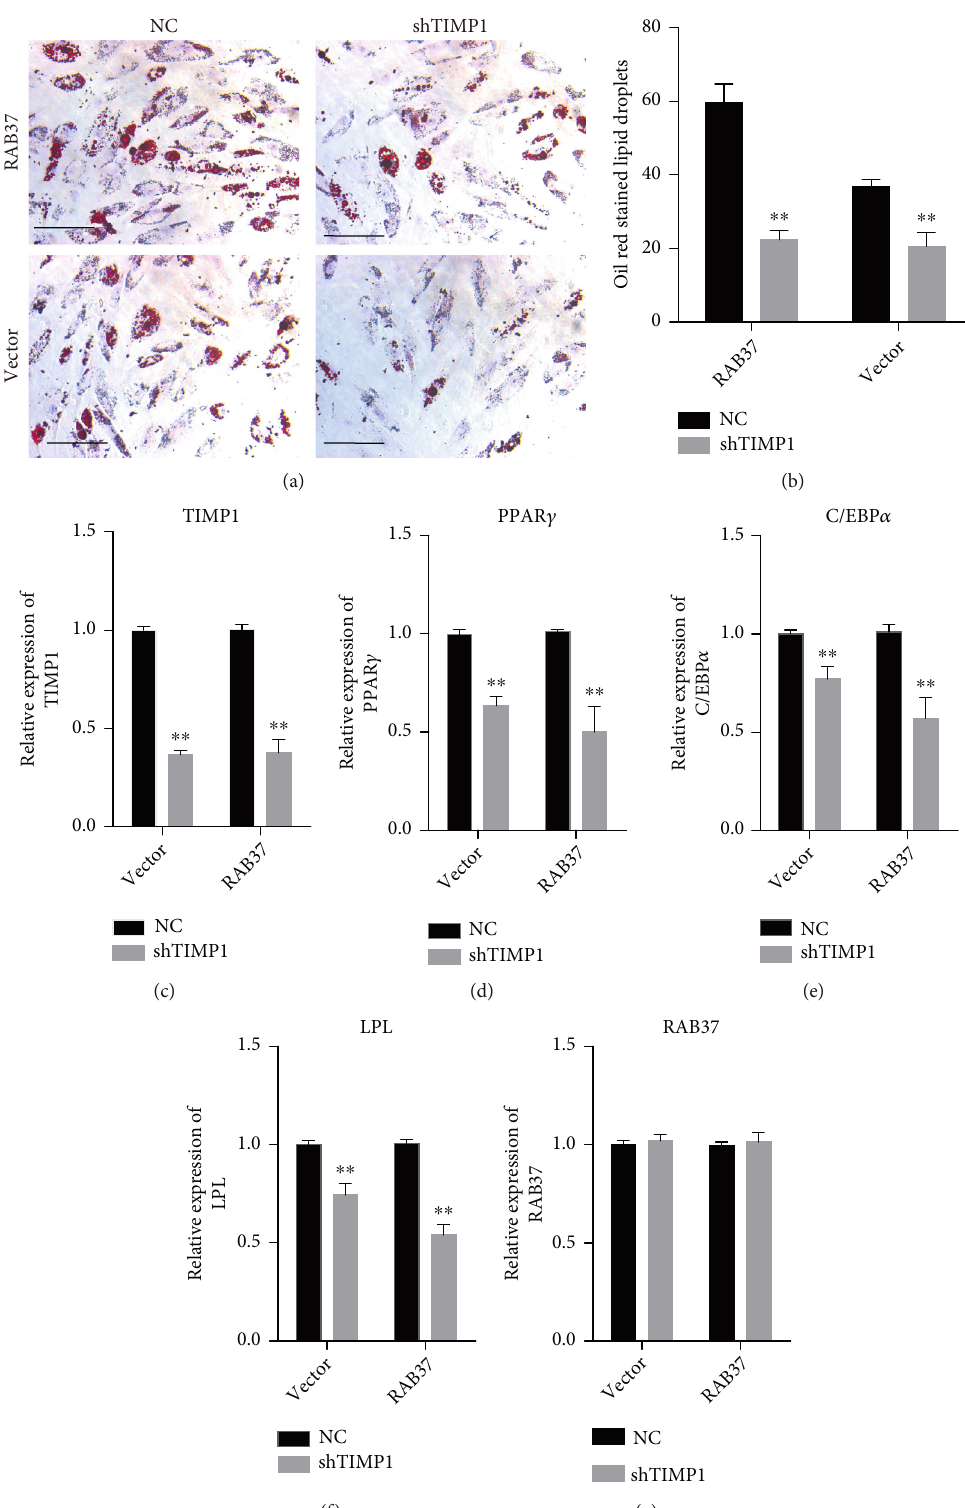
Figure 4: Knockdown of TIMP1 compromised RAB37-mediated adipogenic di ff erentiation. The lentivirus expressing shRNA targeting TIMP1 (lv-shTIMP1) was used to inhibit endogenous expression of TIMP1 in hADSCs-RAB37 and hADSCs-vector. Lentivirus expressing a scramble RNA (NC) was used as control. Adipogenic di ff erentiation was evaluated by Oil Red O staining (a) ( scale bar = 300 μ m ). Oil Red O-stained hADSCs in six random views were counted (b), n = 6 . The expression of TIMP1 (c), PPAR γ (d), C/EBP α (e), and LPL (f) were examined by qRT-PCR, n = 3 . Data are presented as mean ± SD . ∗∗ p < 0 : 01 ; NC vs.